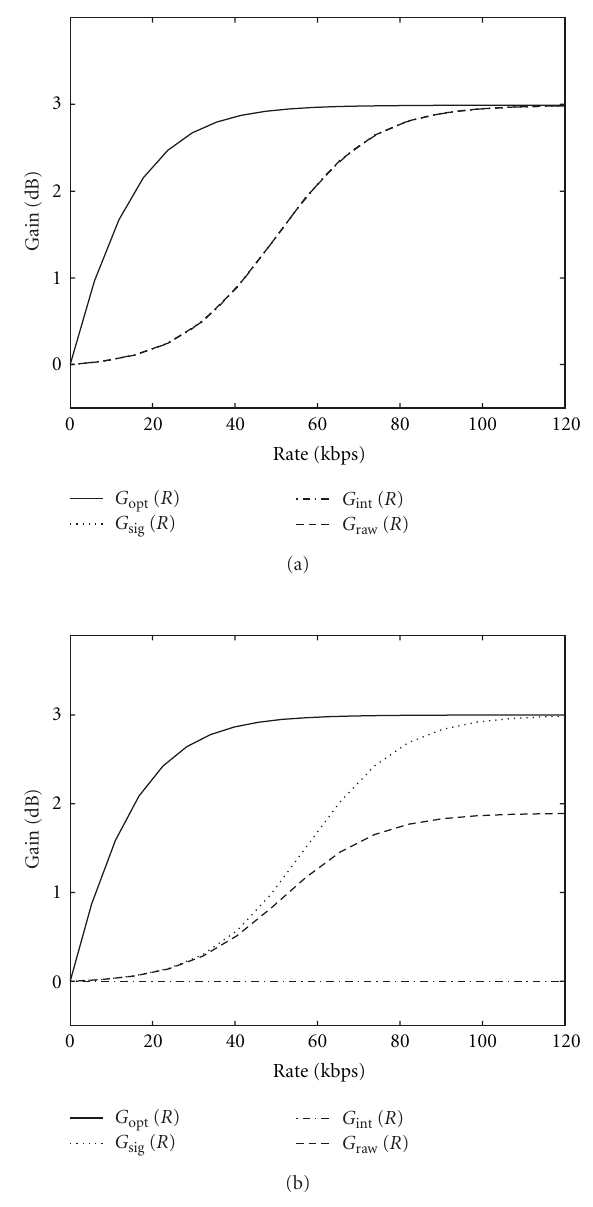
Figure 4: Performance gain for the three schemes when a desired signal is observed in the presence of uncorrelated noise (i.e., SIR = ∞ ). (a) K = 1, (b) K = 2.